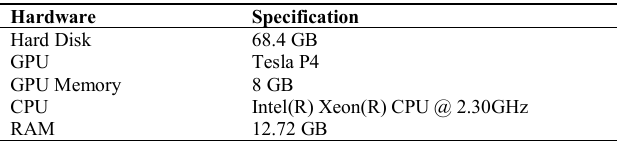
TABLE 3 G OGGLE C OLAB H ARDWARE S